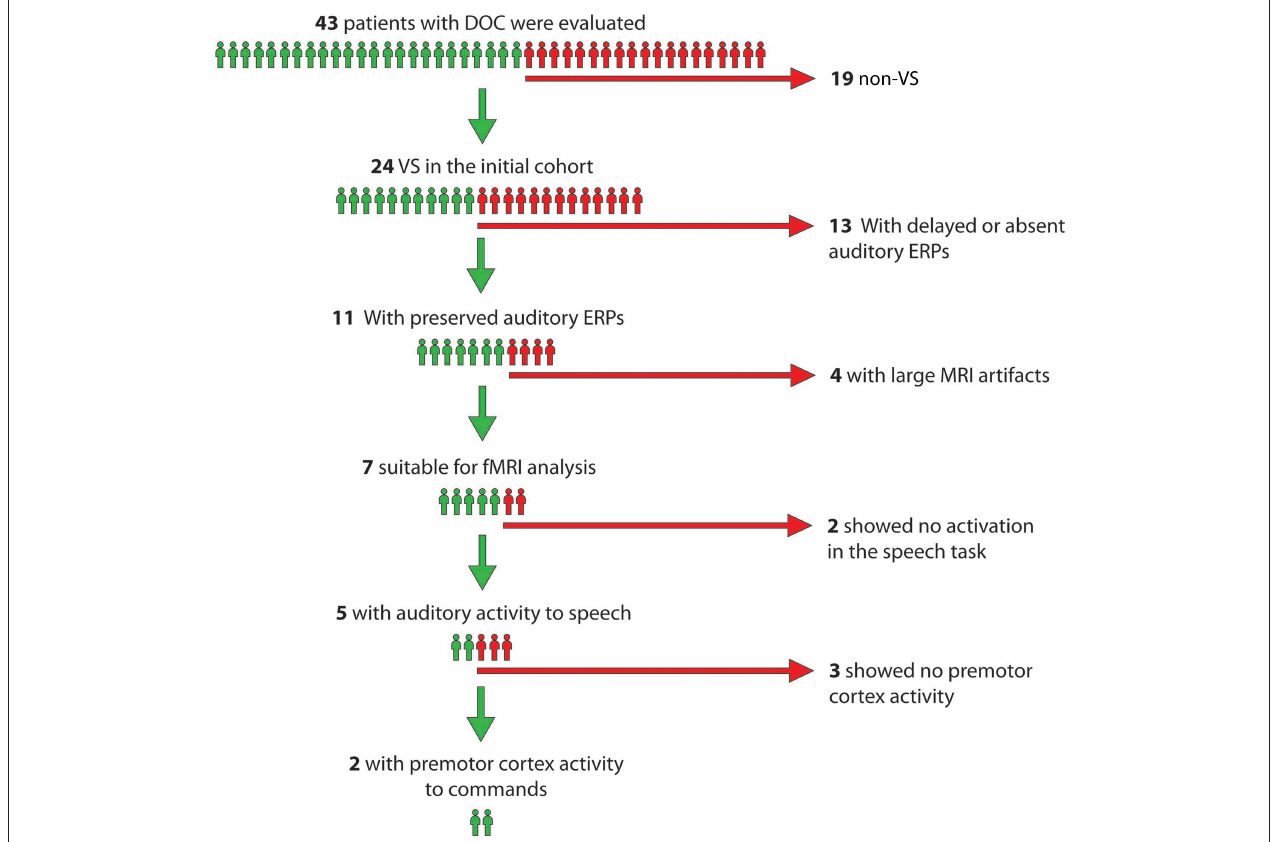
Figure 1 | Flow chart of patient selection in each step of the